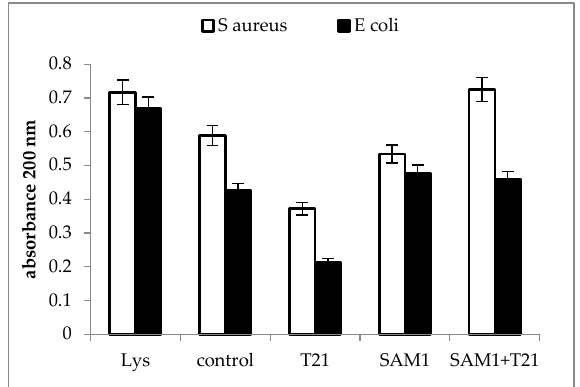
Figure 5. UV absorbance at 200 nm in S. aureus ATCC 33952 and E. coli ATCC 11229 cultures after treatment with T21, SAM1, and SAM1 + T21 (concentration of compounds and combinations: T21 0.5%; SAM1 1MIC; SAM1 1MIC + T21 0.5%).